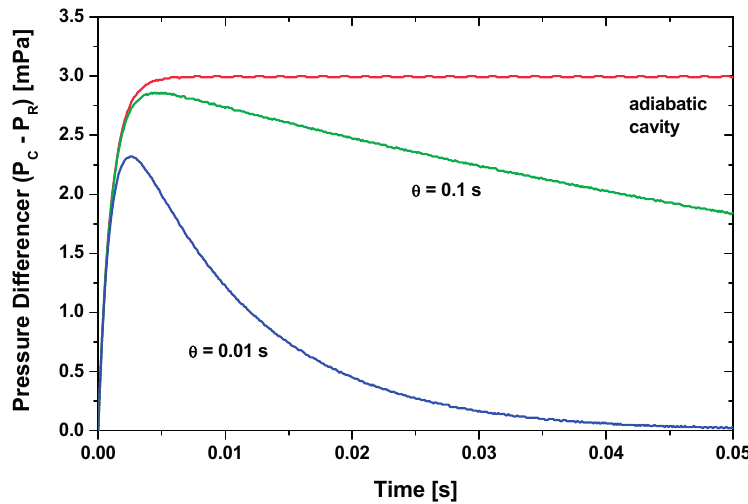
Figure 10. Time-dependent pressure difference between the non-adiabatic cavity and the reservoir as a function of the heat loss from the cavity and Ω = 1000, γ = 3000 ( I 0 = 10 W/m 2 ), τ C = τ R = 0.001 s for equal size of cavity V C and reservoir V R .